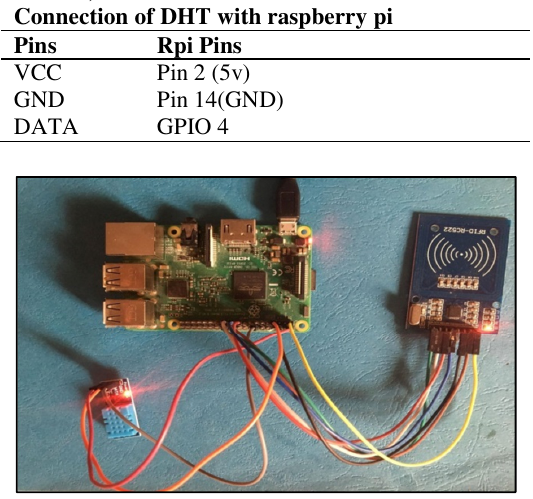
Fig. 5. Sensors connection with raspberry pi.